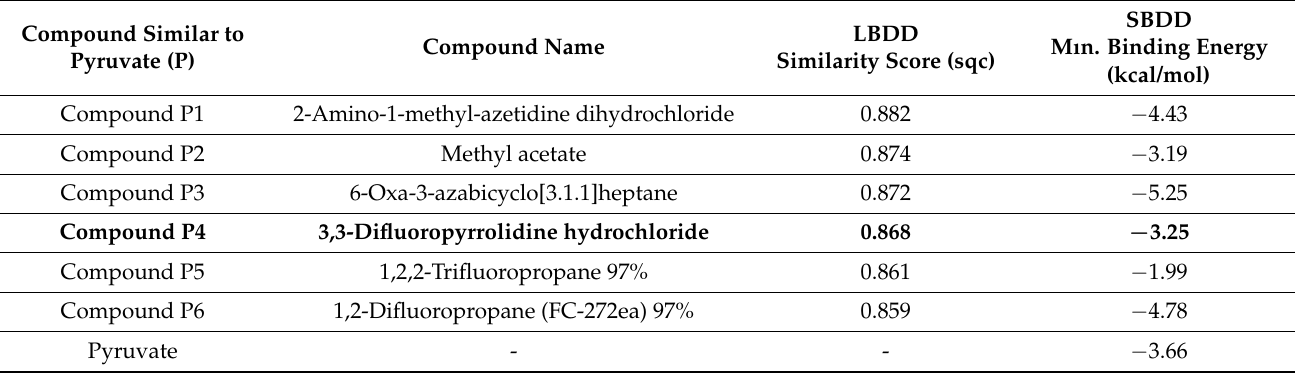
Table 1. Similarity scores from ligand-based drug design, and minimum binding energies from structure-based drug design for the compounds that were structurally similar to pyruvate (P). The row in bold indicates the compound that was selected for inhibition